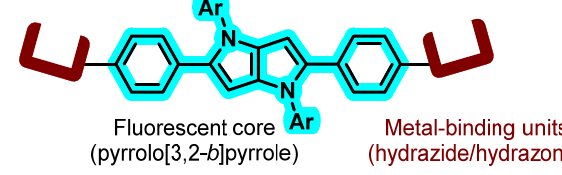
Figure 1. Design of compounds 1 – 6 .